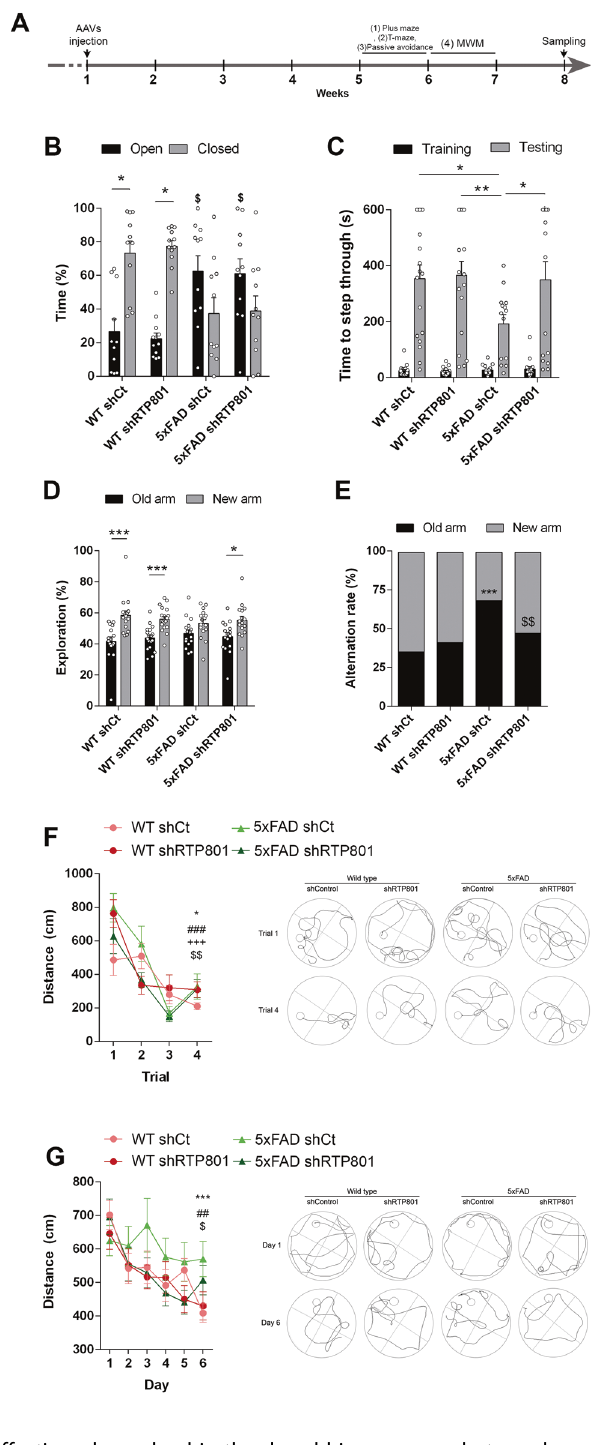
affecting plaque load in the dorsal hippocampus but no changes were found between 5xFAD shCt and 5xFAD shRTP801 animals (Supplementary Fig. 2). Next, we investigated whether RTP801 downregulation was affecting synaptic plasticity. Golgi – Cox staining showed no differences in spine density between the four groups (Fig. 4A, B). No signi fi cant differences were observed in the size of the head area of these spines either (Fig. 4C). However, silencing RTP801 in 5xFAD animals rescued the excessive neck length of their dendritic spines (Fig. 4D). Regarding the levels of synaptic proteins, we observed that RTP801